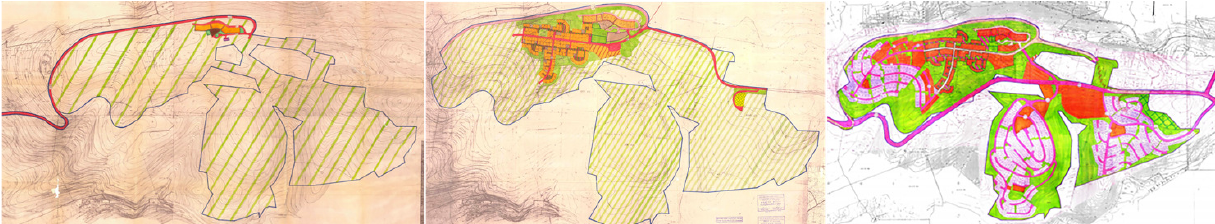
Figure 8. Mitzpe Katzir in 1981, 1985, and 1994. Sources: The Jewish Agency for Israel (1981), Arye Sonino Architects (1985), and Lavi‐Bar Architects and Planners (1994).